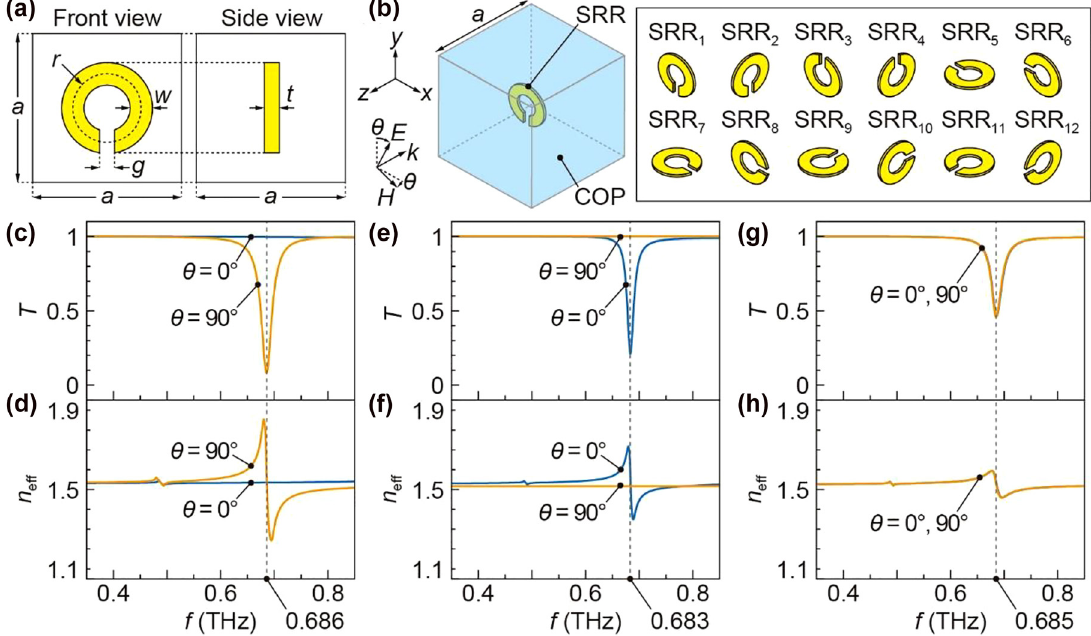
Figure 2: (a) Design of a resin grain containing a single SRR. (b) The unit cell for a calculation model containing one of the 12 types of differently-directed SRRs from SRR 1 to SRR 12 . (c) and (d) Simulationresults of the transmittance and effective refractive indexfor a calculation model containing SRR 1 . (e) and (f) Simulation results for a calculation model containing SRR 2 . (g) and (h) The transmittance and effective refractive index obtained from the average S parameters of 12 types of SRRs. The results with x -axis polarized wave ( θ = 90 ° ) and y -axis polarized wave ( θ = 0 ° ) almost